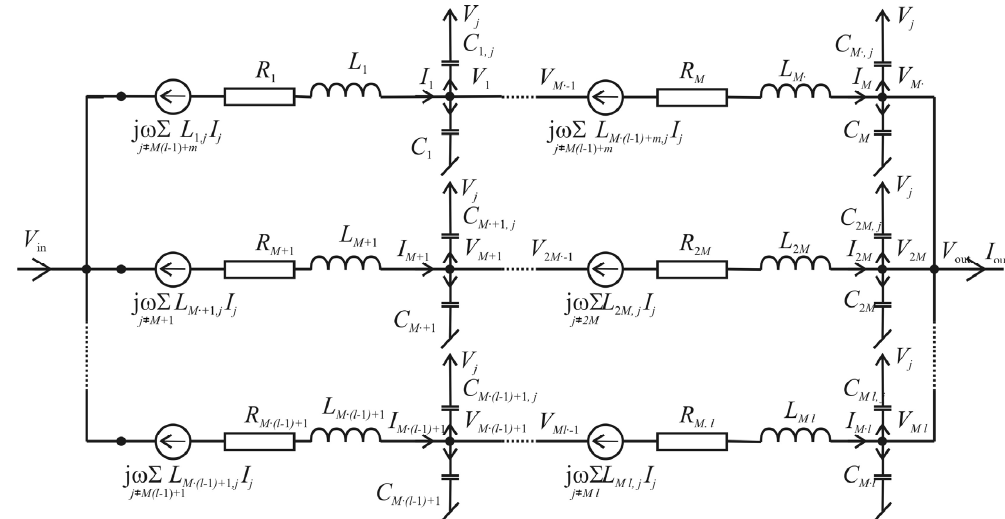
Figure 3. Input and output elements in the setup of parallel coils, based on the single element from Figure 2.